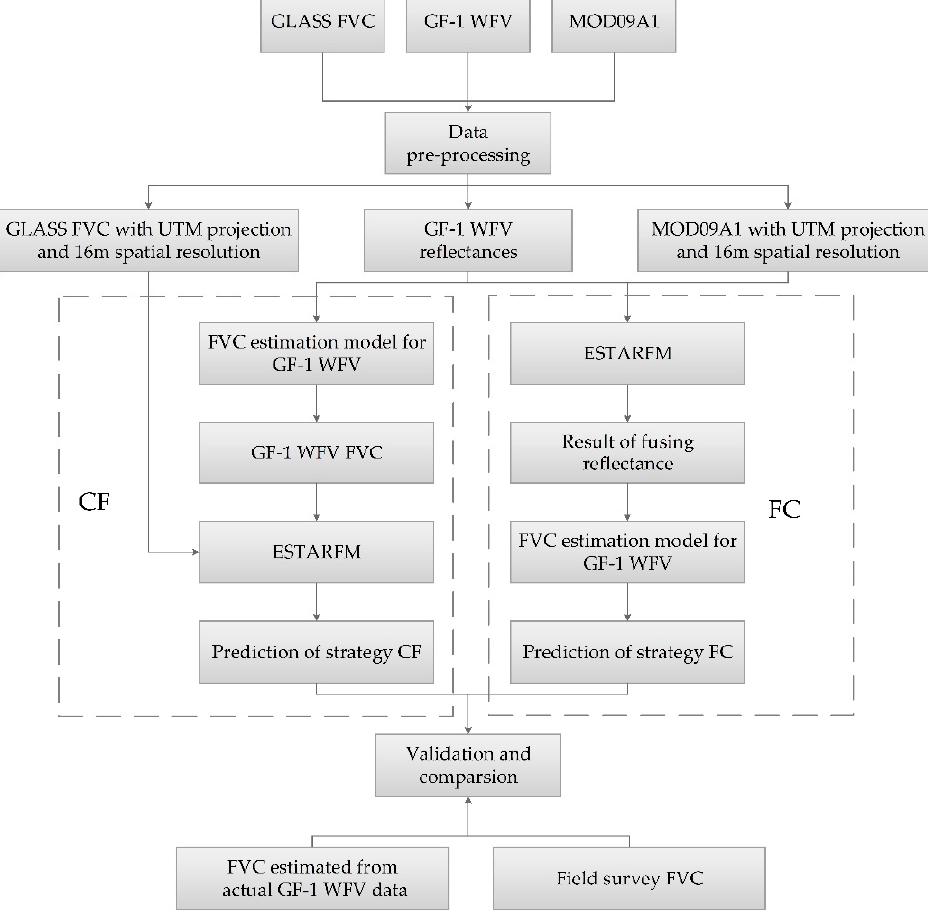
Figure 3. The flow chart of this study.